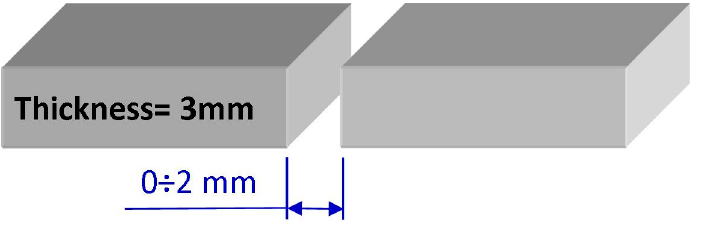
Figure 3. A scheme for preparing elements for MAG welding supported by the micro-jet cooling method, thickness t = 2 mm.